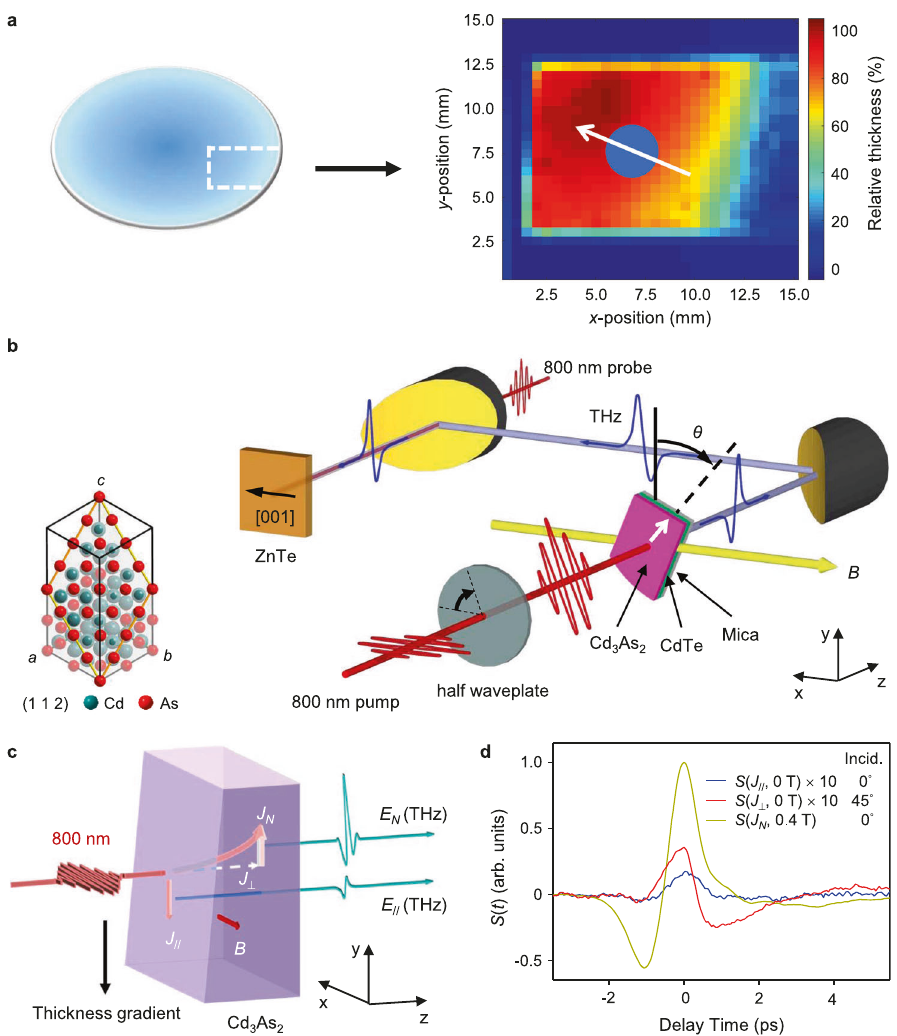
Fig. 1 THz emissions from Cd 3 As 2 epitaxial fi lm with a thickness gradient. a The position of a cut piece (white dash line region) in an as-grown wafer, and the mapping of relative thickness of the Cd 3 As 2 fi lm determined by two-dimensional scanning of laser transmittance. The blue circle marks the excitation laser spot and the arrow illustrates the direction of thickness gradient on the spot. b Schematic diagram of experimental setup, where θ denotes the azimuthal angle of the sample with respect to y -axis. Inset: the crystal structure of Cd 3 As 2 along (112) plane. c Schematic diagram of THz emissions from transient current generated by 800-nm optical excitation. E N and E // here denote the instantaneous electrical fi eld of THz emission from Nernst current ( J N ) under magnetic fi eld and from the in-plane current ( J // ), respectively. J ⊥ denotes the out-of-plane current. d Typical THz waveform generated by J // , J ⊥ and J N in ( c ). The two THz waveforms from J ⊥ and J N are obtained by sample tilting and by applying an in-plane magnetic fi eld THz waveform changes with θ as shown in Fig. 2c. The peak shown in Fig. 2d. According to the cosinoidal fi tting shown in Fig. 2d, we fi nd the THz polarization direction is along the direction of thickness gradient of Cd 3 As 2 fi lm with accuracy of 6.2 ° . This azimuthal angle dependence of THz emission is con- sistent with that the THz emission is generated via the in-plane Seebeck current J // induced by thickness gradient 16 as discussed above.